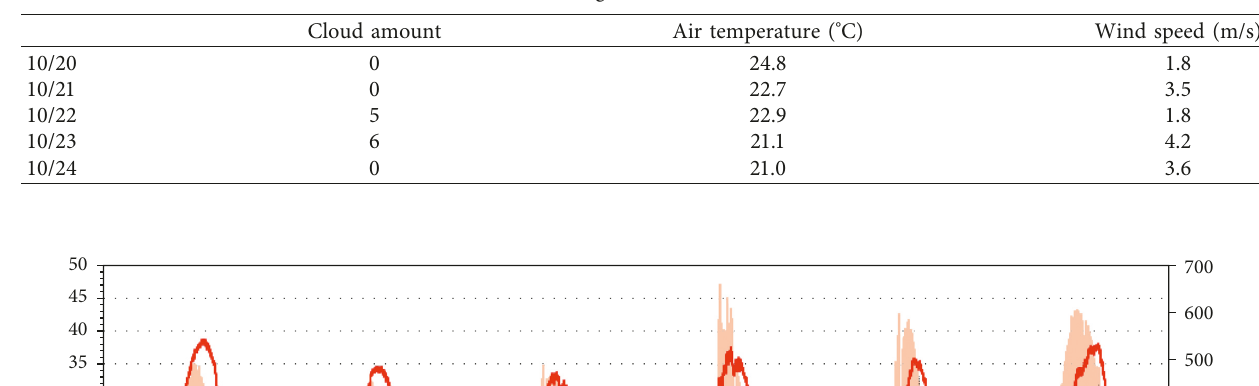
Figure 8: Scale-model experiment finish colors (Test Table 9: Average weather data of Test 2.